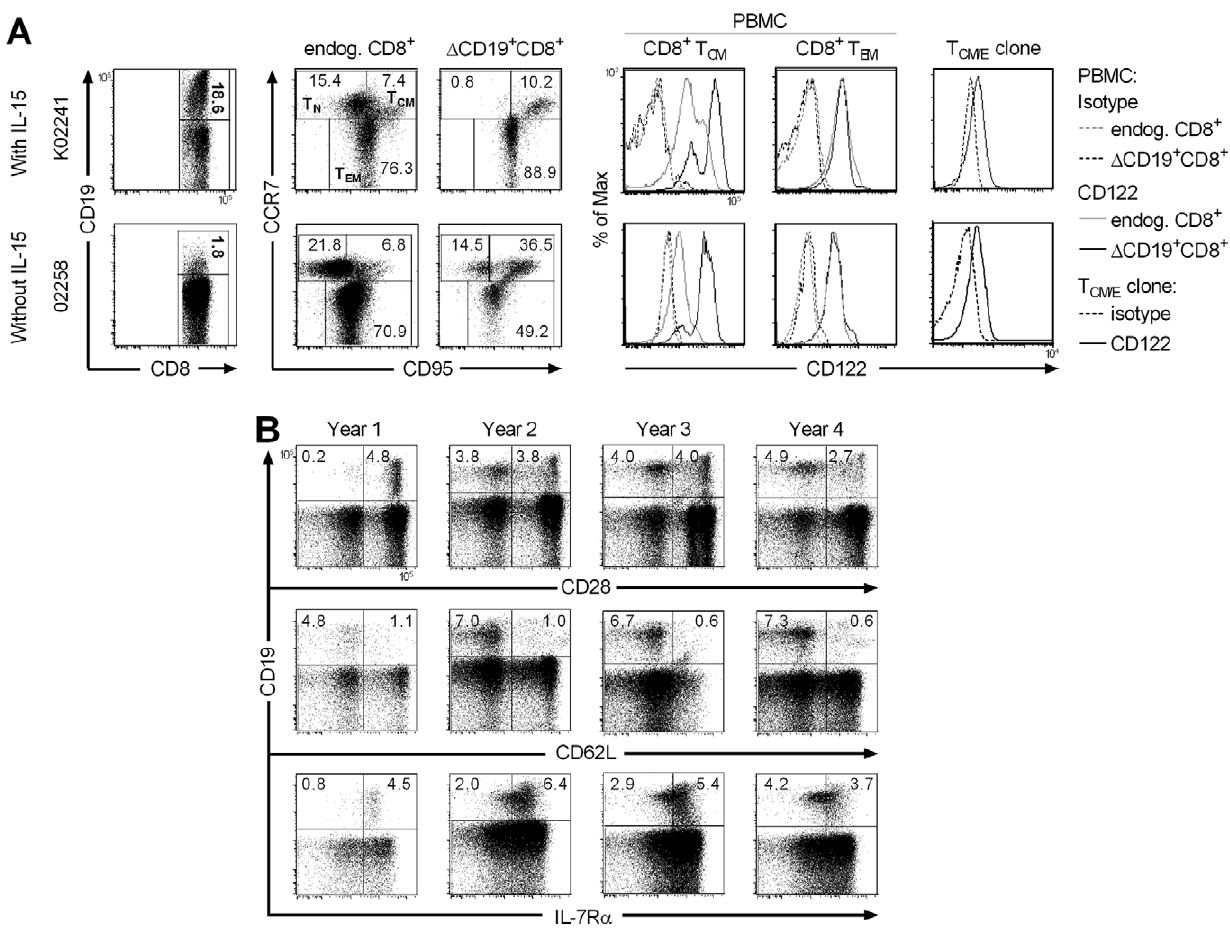
Figure 6. T CM/E adopt CD122 intermediate T EM , and CD122 intermediate/high T CM -phenotypes regardless of IL-15 and persist long-term. (A) Samples of PBMC were obtained . 8 weeks after adoptive transfer of a D CD19 + CD8 + T CM/E clone with or without IL-15. D CD19 + CD8 + T CM/E were identified in PBMC by staining with mAbs to CD3, CD8, and CD19, and anti-CCR7 and anti-CD95 mAbs were used to identify CCR7 + CD95 + T CM and CCR7 – CD95 + T EM subsets. Inset values show the frequency (%) of T cells in each subset. Cells were also co-stained with an anti-CD122 mAb to determine the expression of CD122 in the endogenous D CD19 – CD3 + CD8 + (gray solid line) and transferred D CD19 + CD3 + CD8 + (black solid line) T M subsets. Isotype-matched mAbs were used as control (black/gray dashed lines). Expression of CD122 (back solid line) and the isotype control (black dashed line) on the infused T CM/E clone is shown in the far right panels. Data are representative for results in 5 animals receiving infusions of D CD19 + CD8 + T CM/E cells with or without IL-15. (B) PBMC were obtained from macaque K02241 at yearly intervals after the infusion of a D CD19 + CD8 + T CM/E clone with IL-15. The frequency of the transferred D CD19 + T cells (%) within the CD3 + CD8 + T cell subset was determined by flow cytometry after staining with mAbs to detect expression of CD3, CD8, and CD19. Samples were co-stained using mAbs to detect expression of CD28, CD62L, and IL- 7R a , and examined by flow cytometry after gating on CD3 + CD8 + T cells. Inset values show representative data of the frequency (%) of T cells in each subset.